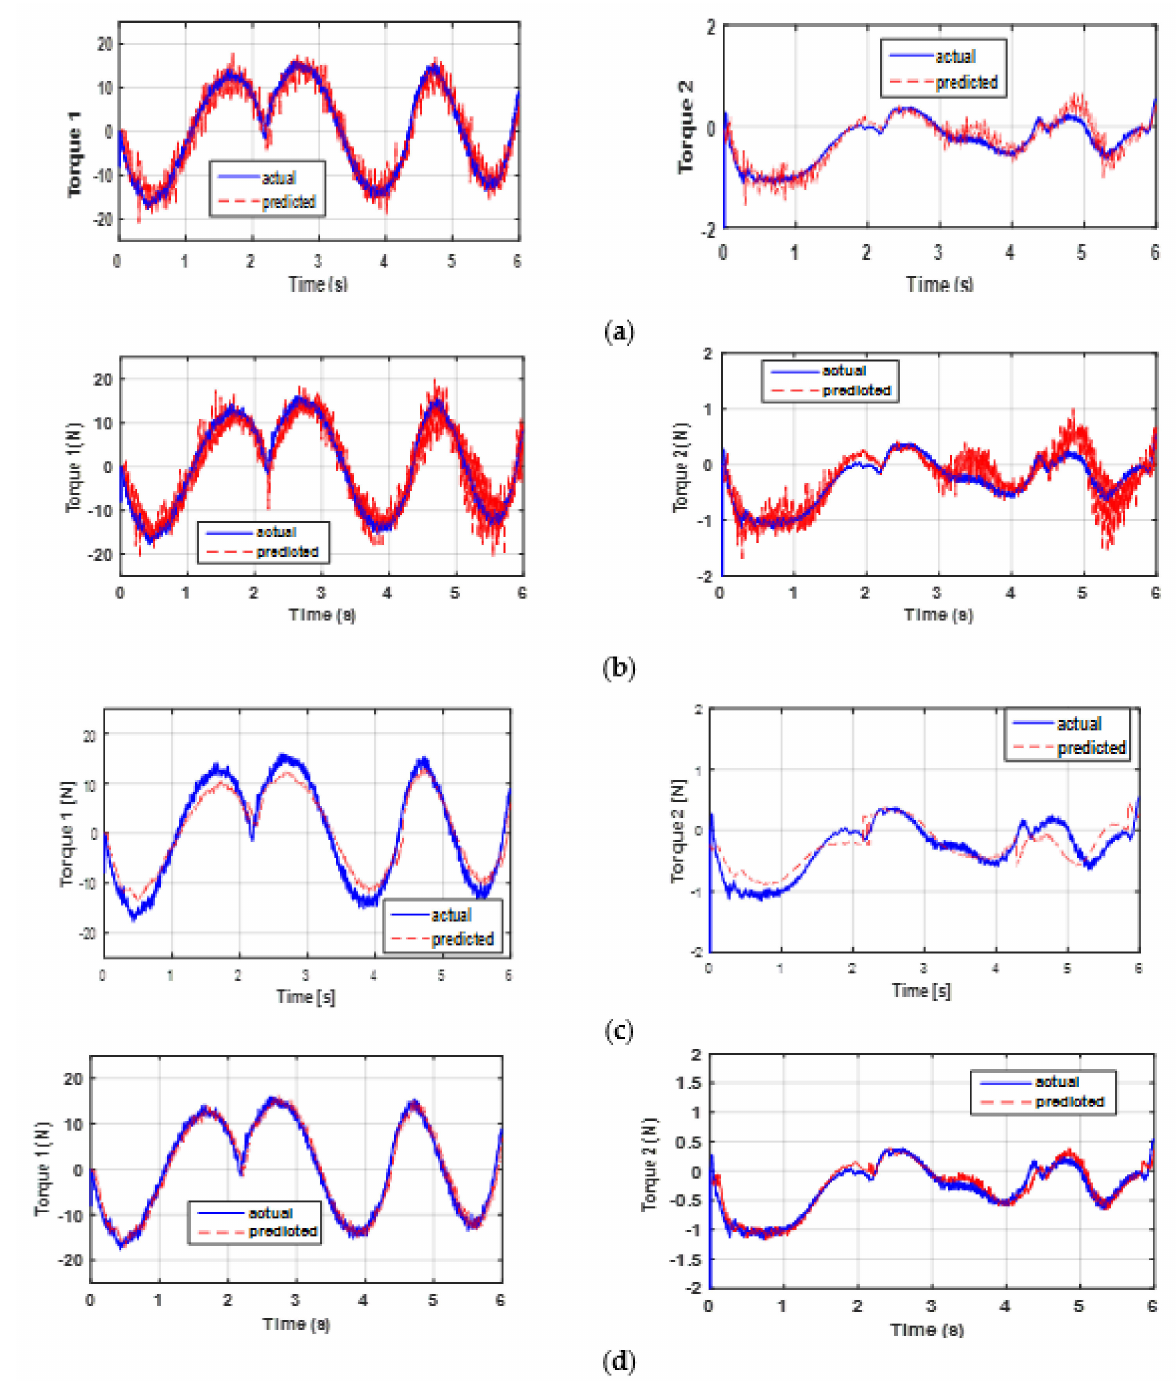
Figure 7. Actual and predicted torques: direct validation through ( a ) ED+FIR, ( b ) the 2SMD algorithm, ( c ) the ASTD algorithm, and ( d ) the P2SMD